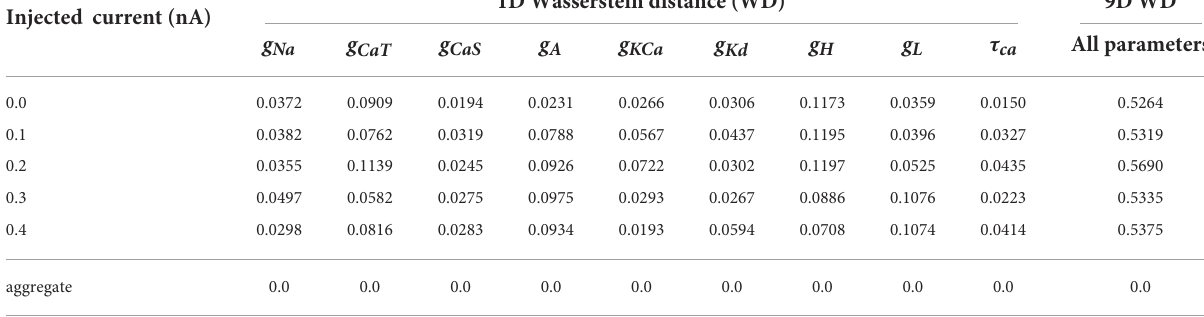
ThedistancesareorganizedaccordingtothedimensionalityoftheWassersteindistanceused:Wassersteindistancesforsingleparametersposteriorsusetheone-dimensional(1D)distance while “all parameters” use the nine-dimensional (9D) distance. The 9D distance includes the entire nine-dimensional posterior as a group rather than the one-to-one comparisons of the 1Ddistance.ThefinalrowshowstheWassersteindistancesfortheaggregatecurrentconstraint.AllthesevaluesarezeroasitistheWassersteindistancetooneself.